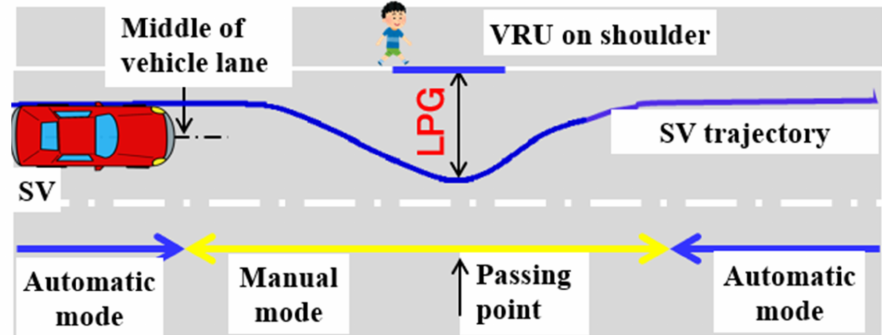
Figure 2. Experimental procedure of a VRU overtaking